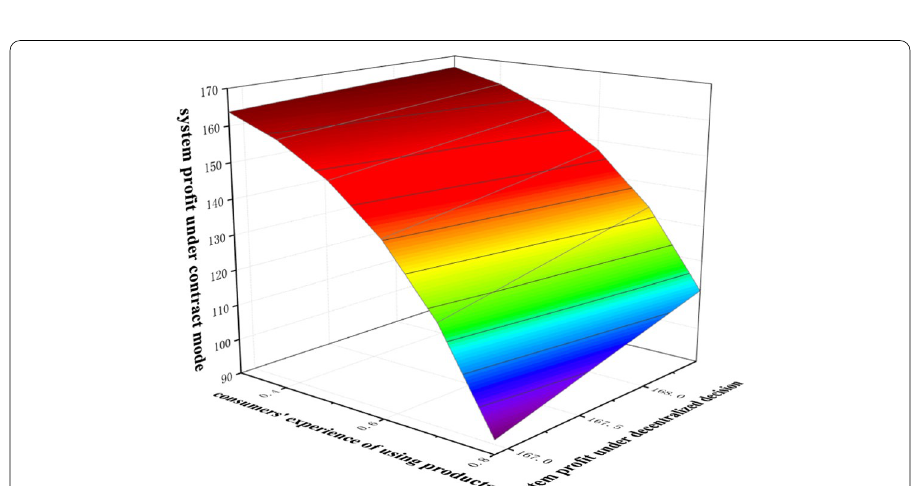
Fig. 5 Change of system profit π sc with consumer’s experience in using products